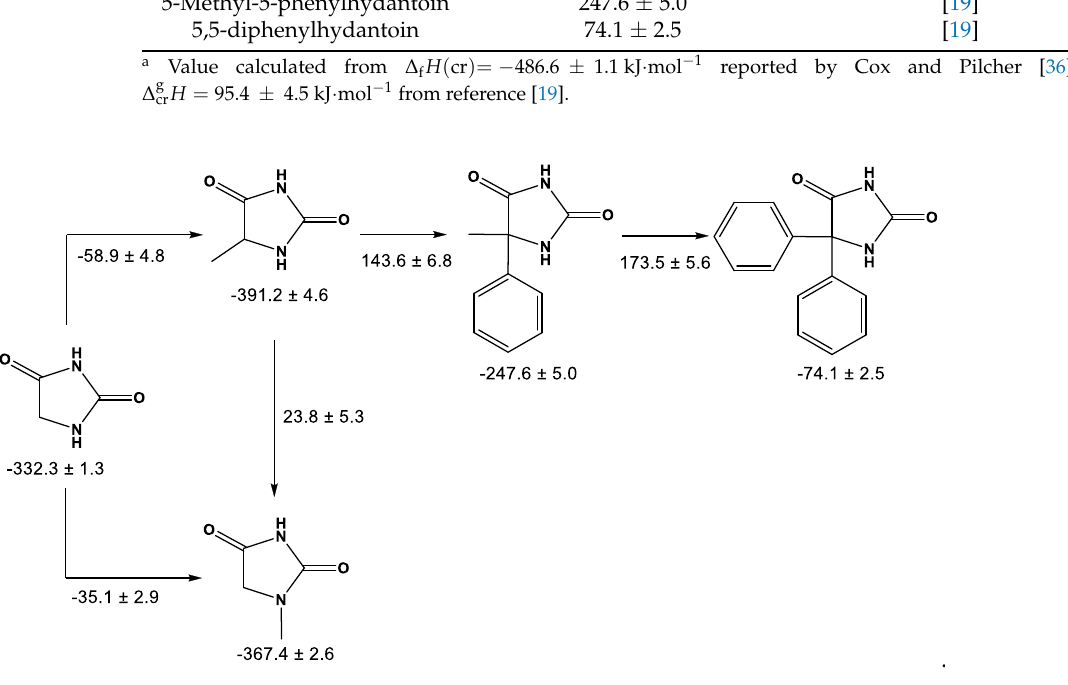
Figure 2. Comparative diagram of gas-phase enthalpies of formation of the 5 imidazolidine deriva- tives: 5,5-diphenylhydantoin, 5-methyl-5-phenylhydantoin, hydantoin, 5-methylhydantoin, and 1-